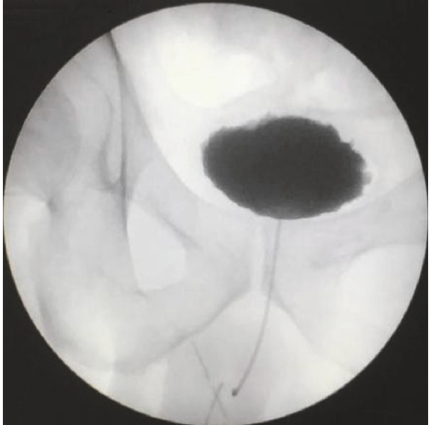
Figure 3: Retrograde cystography at 40th